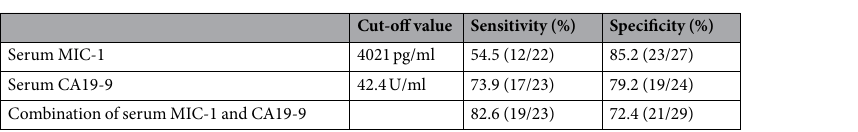
Table 5. Diagnosis of biliary tract cancer by the combination of serum MIC-1 and serum CA19-9. MIC-1 , macrophage inhibitory